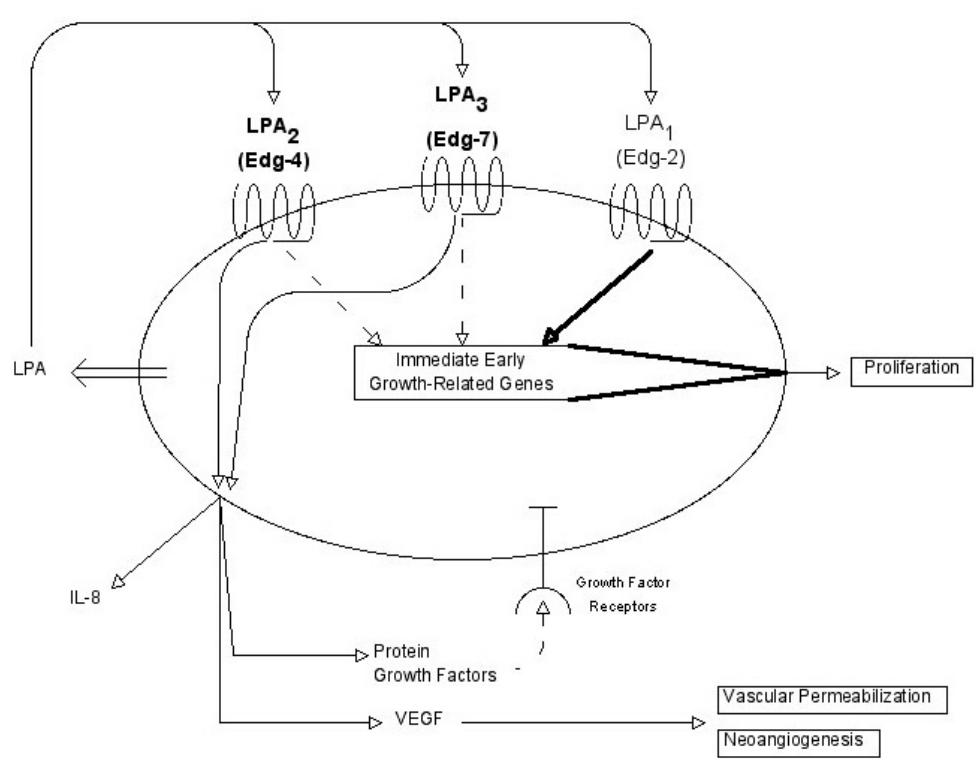
FIGURE 3. LPA and LPA receptors in ovarian cancer. Dashed line with arrow = stimulation, heavy solid line with arrow = inhibition, IL-8 = interleukin-8, VEGF = vascular endothelial growth factor. human ovarian cancer tissue samples. S1P3 (Edg-3) and S1P2 (Edg-5) R mRNA also were consistently higher in OSE cells than in OCCs. Edg-1 R was expressed at similarly low levels in all lines of ovarian cells. Western blots supported the findings of higher levels of LPA2 (Edg-4) and LPA3 Rs in OCCs than nonmalignant ovarian epithelial cells, and higher levels of LPA1, S1P2, and S1P3 Rs in OSE cells than OCCs (Fig. 3). Thus it was expected that OCCs would be more responsive functionally to LPA and normal ovarian cells to